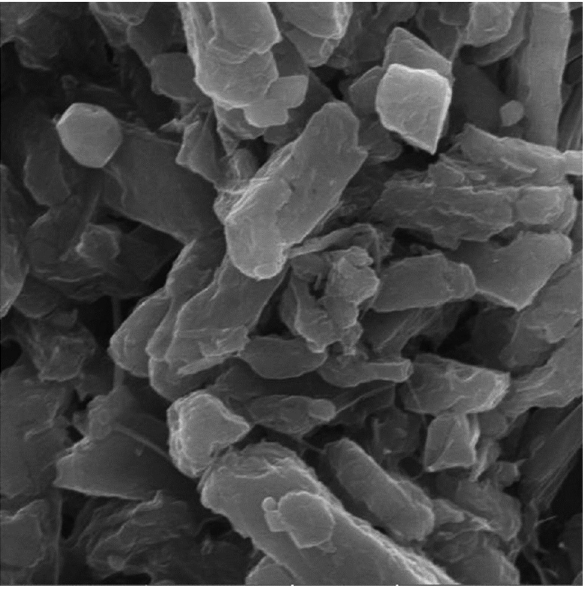
Figure 3: FT - IR results of clodinofop